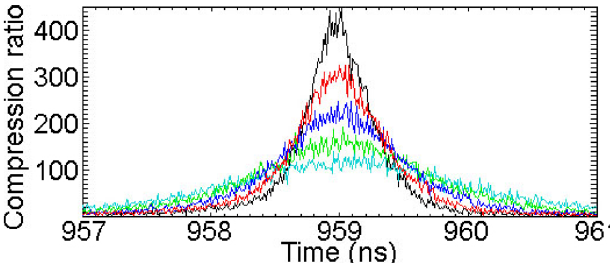
(cid:2) t (cid:3) =I comparison using b 0